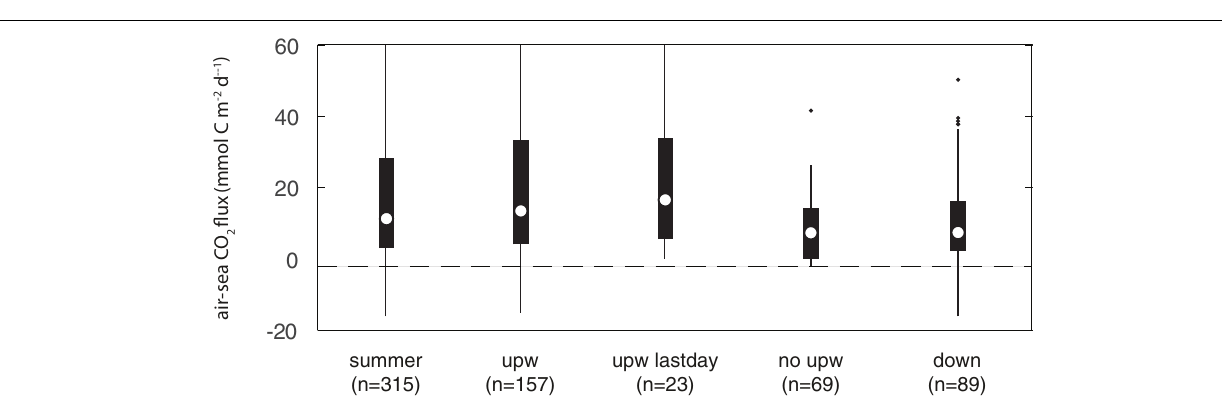
FIGURE 10 | Box plot of the daily mean air-sea CO 2 flux of the full sample (summer), the upwelling days (upw), the last days of the upwelling event (upwlastday), the no-upwelling days (no upw) and downwelling days (down). Circle indicates median, boxes the range 25th and 75th percentiles, lines extend to the most extreme data and dots are